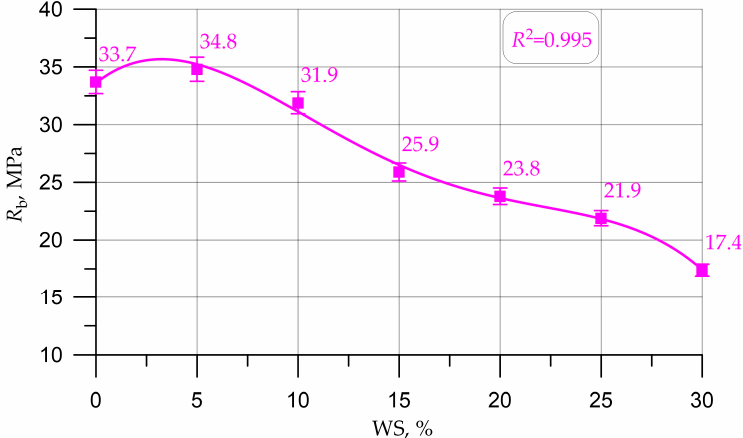
Figure 7. Dependence of the prism strength of concrete on the amount of walnut shell.